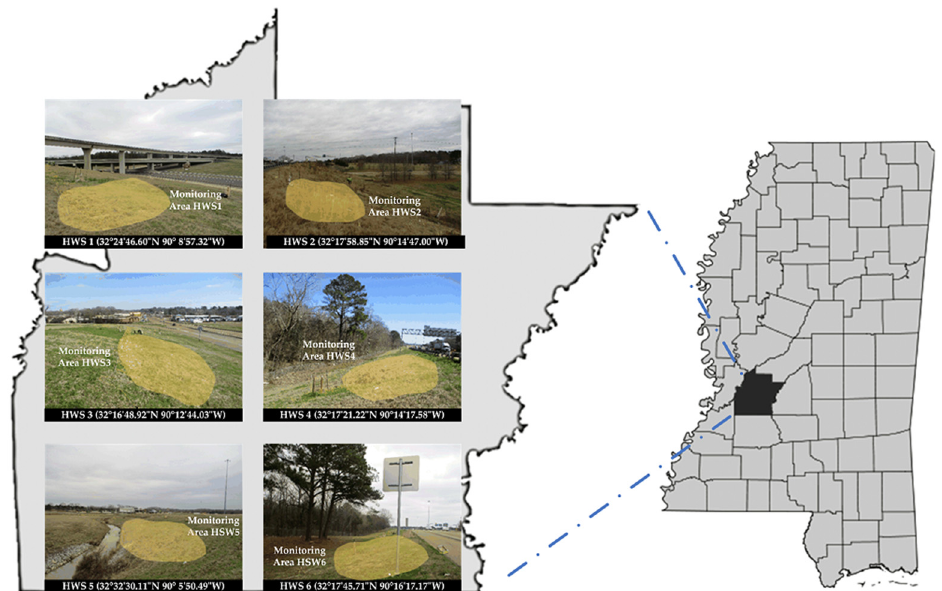
Figure 2. HWS locations (Reference Sites), Jackson.